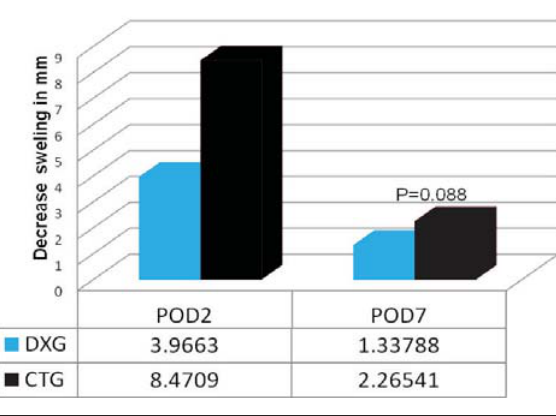
Figure 2. Effect of dexamethasone on post-operative swelling Trismus